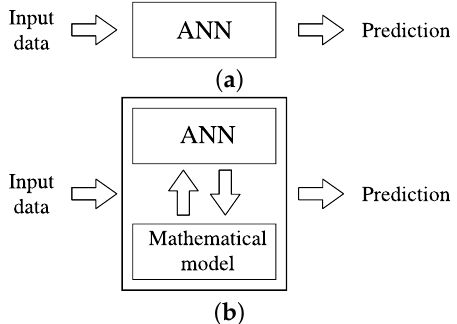
Figure 1. The comparison of two approaches to the prediction problem with use of an ANN ( a ) black box ( b ) combination of a mathematical model and ANN grey